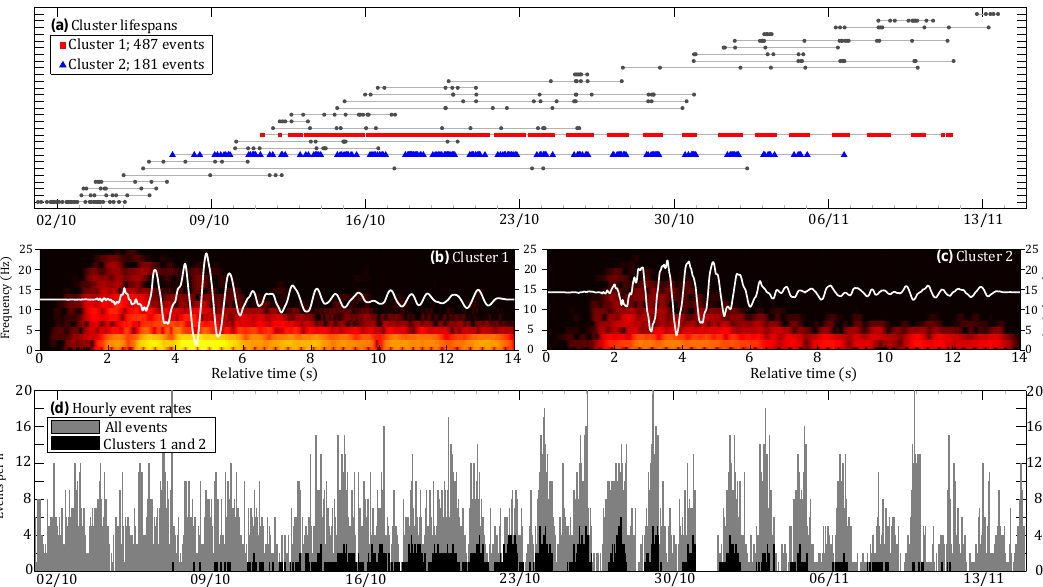
Figure 3. (a) Catalogue of cluster occurrence in our data set from 1 October to 15 November 1994. Each plotted point represents an earthquake, and earthquakes on the same line are part of the same cluster. Only clusters with five or more events are shown. The two largest clusters, clusters 1 and 2, are plotted with red squares and blue triangles respectively. (b) The waveform stack of all events in cluster 1, overlain on a frequency spectrogram of the stack. (c) The waveform stack of all events in cluster 2, overlain on a frequency spectrogram of the stack. (d) Hourly event rates for all events (grey) and events in clusters 1 and 2 (black) during the period of 1 October to 15 November